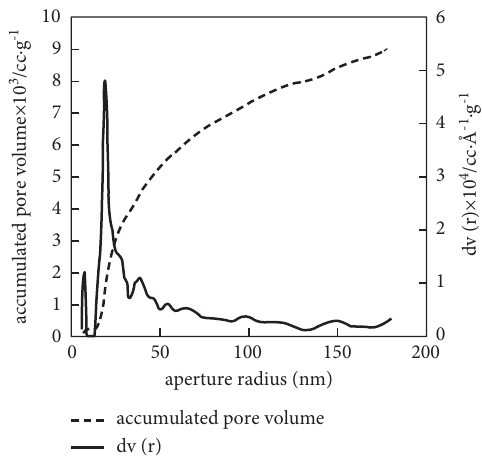
Figure 2: Cumulative (left y -axis) and differential (right y -axis) pore size distribution for Bulianta 12# raw coal sample.